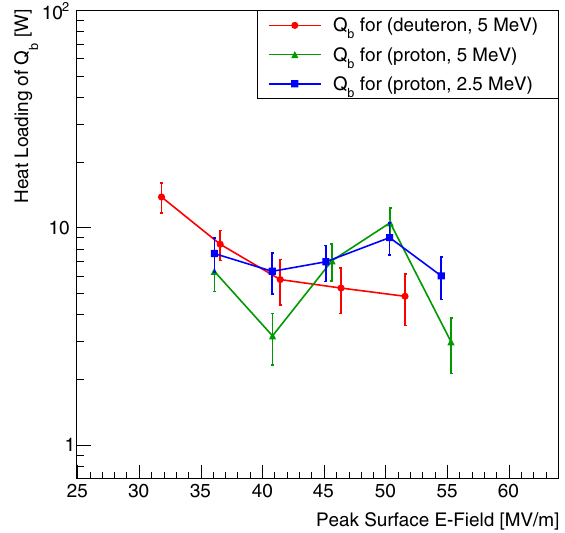
FIG. 12. Heat loading owing to beam loss as a function of peak surface-E field. Q shown in vertical axis correspond to the heat b loading due to “ theoretical transmission ” shown in Fig. 11.